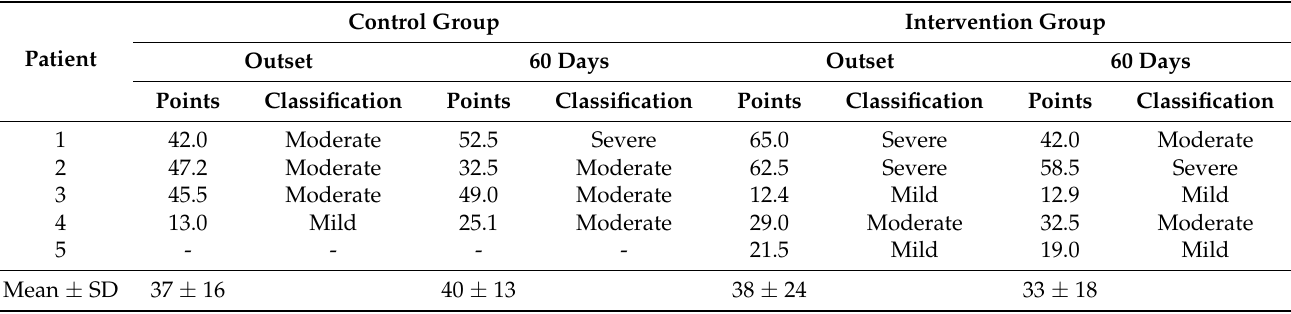
Table 3. Disease severity score (SCORAD) at the beginning of the study and after 60 days of treatment with cold creams CBlank (Control) and CPropolis (Intervention).